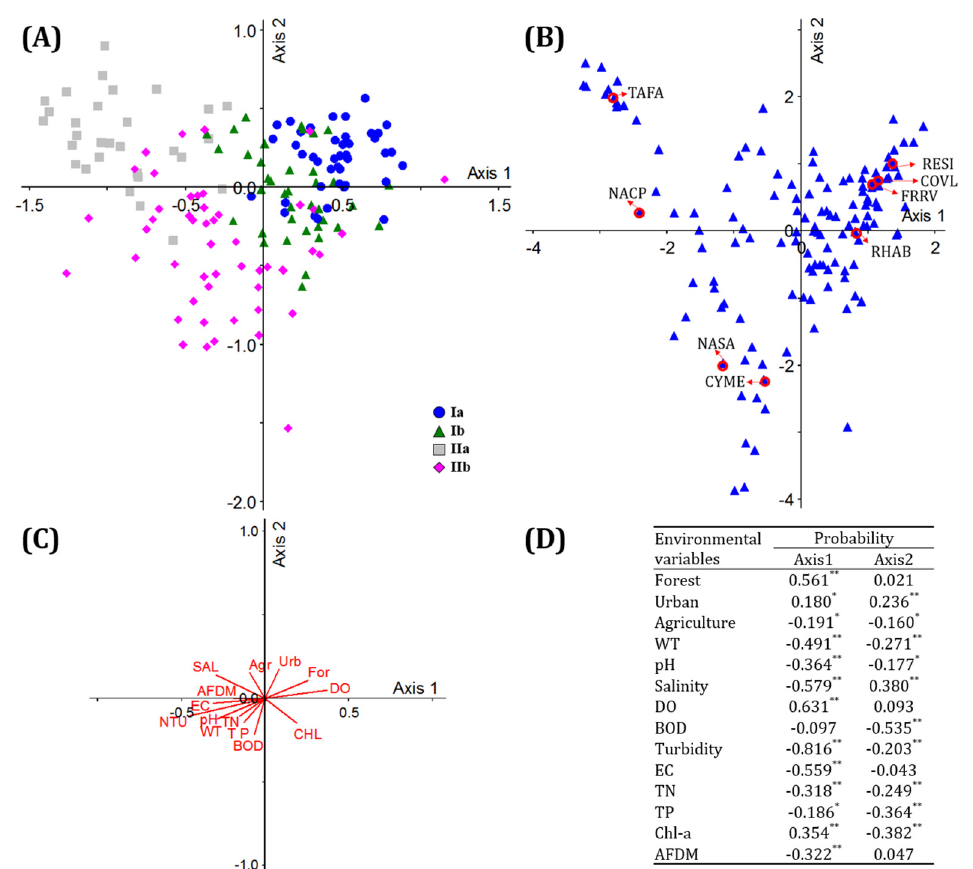
Figure 3. ( a ) CCA ordination showing the distribution of four diatom groups in Korean estuaries between 2012 and 2014; ( b ) Distributions of epilithic diatoms, including indicator species; ( c ) Environmental variables affecting epilithic diatom distribution; ( d ) Correlation coefficients between environmental variables and CCA Axes-1 and 2. * p < 0.05, ** p < 0.01 For: forest, Urbe: urban, Agr: agriculture, WT: water temperature, SAL: salinity, DO: dissolved oxygen, BOD: biochemical oxygen demand, NTU: turbidity, EC: electric conductivity, TN: total nitrogen, TP: total phosphorus, chl- a : chlorophyll- a , AFDM: ash-free-dry-matter, NS: no. species, RESI: Reimeria sinuata , COVL: Cocconeis placentula var. lineata , FRRV: Fragilaria rumpens var. fragilarioides , RHAB: Rhoicosphenia abbreviata , TAFA: Tabularia fasciculata , NACP: Navicula capitatoradiata , CYME: Cyclotella meneghiniana , NASA: Navicula salinarum